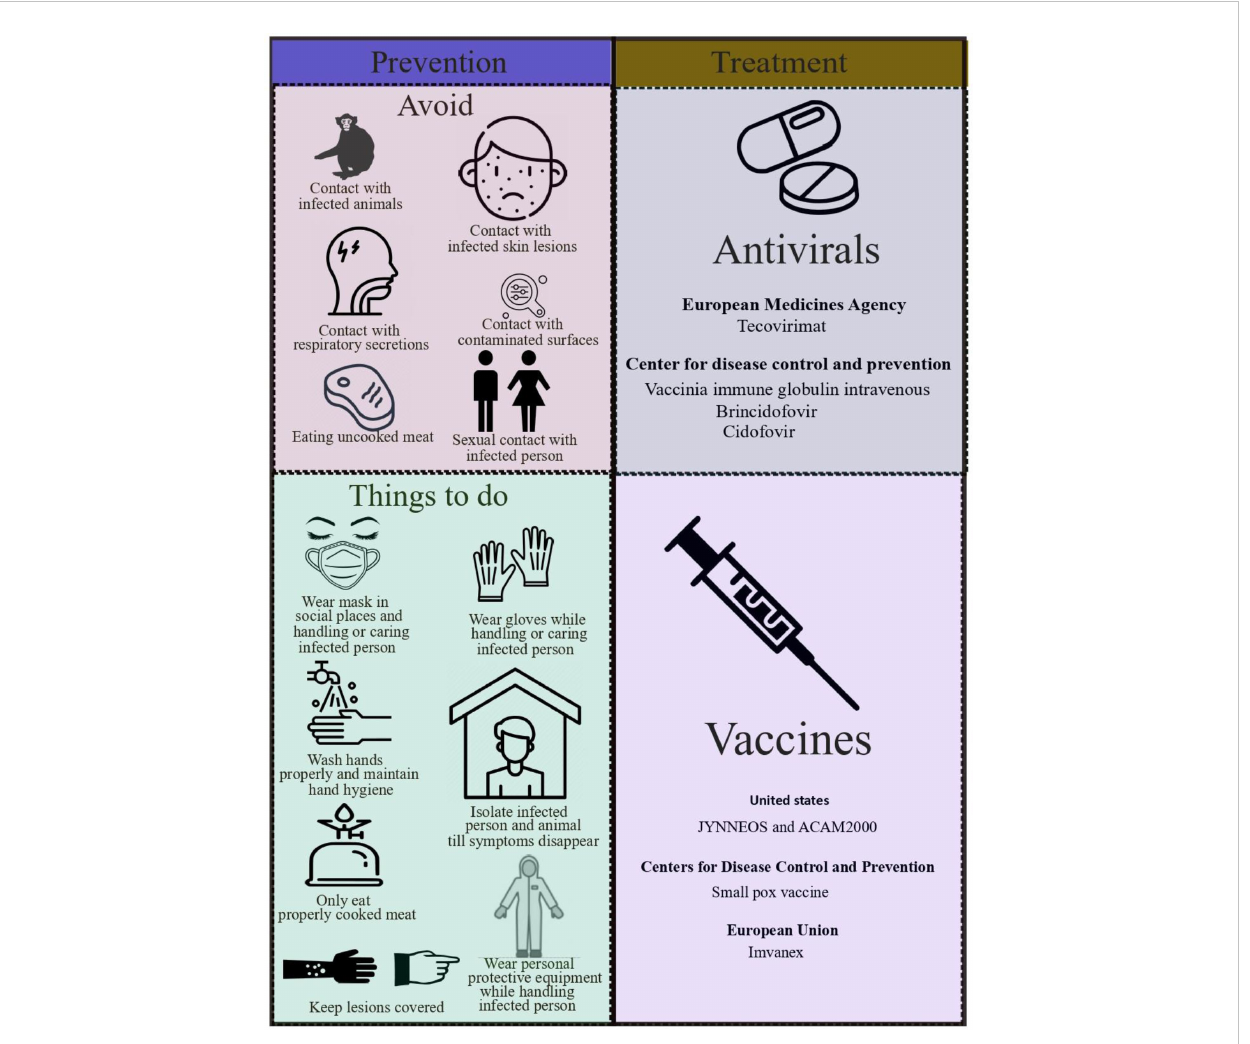
FIGURE 5 Representing prevention and treatment of